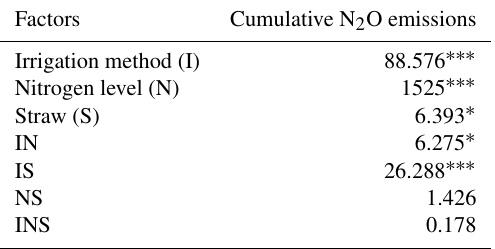
Table 2. Cumulative nitrous oxide (N 2 O) emissions in response to irrigation method, nitrogen level and straw returning. Significant treatment effects within a main category ( P < 0 . 05) were indicated by ∗ and ∗∗∗ indicated significant treatment effects within a main category ( P < 0 .